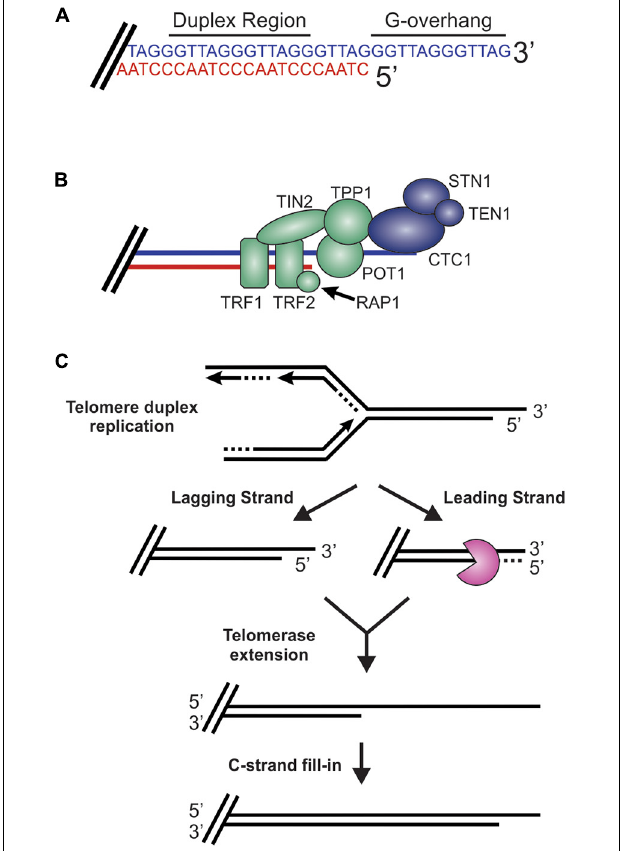
FIGURE 2 | Overview of telomeres. (A) Telomeres consist of a repetitive DNA sequence that forms a duplex DNA region and a 3 (cid:48) G-rich ssDNA overhang (C-strand, red: G-strand, blue). (B) Telomeres are bound by the shelterin complex (TRF1-TRF2-RAP1-TIN2-TPP1-POT1) and the CST complex (CTC1-STN1-TEN1), which aid in telomere maintenance. (C) Steps in telomere replication. First, the telomere duplex is replicated resulting in either a blunt end (leading strand replication) or an overhang (lagging strand replication). The leading strand end is then processed to generate a G-overhang. Telomerase then extends the G-overhangs followed by C-strand fill-in to convert most of the ssDNA to duplex DNA, leaving a short